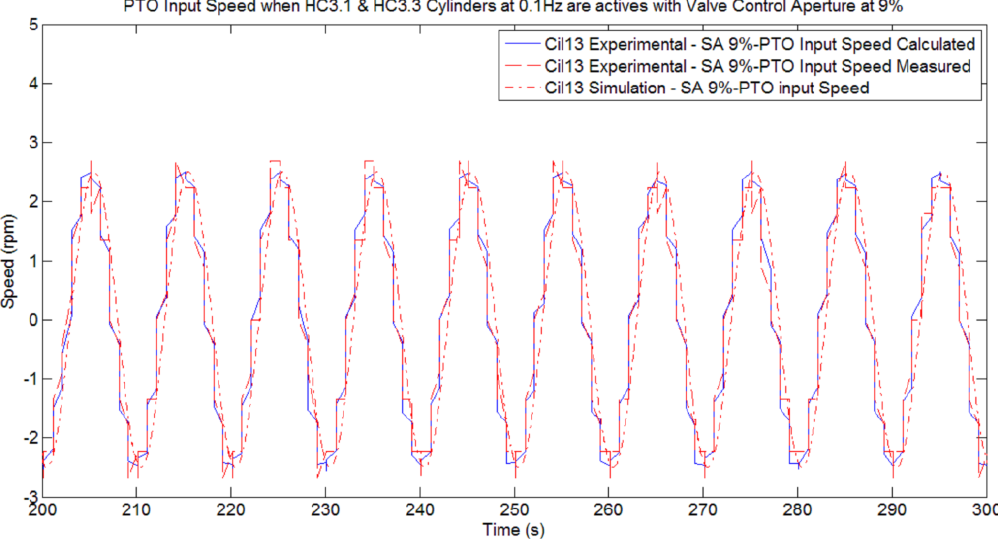
Figure 21. Comparison between Simulated PTO Input speed and Calculated/Measured PTO Input